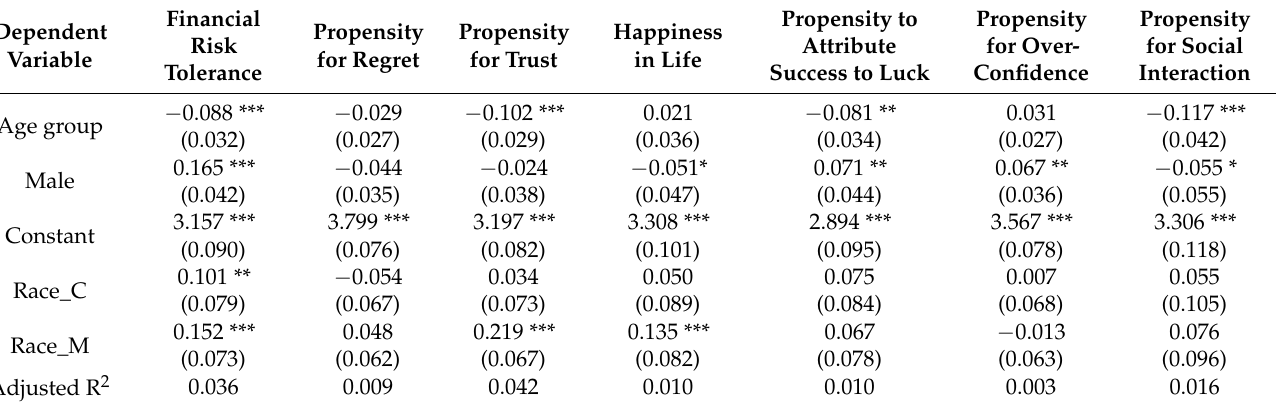
Table 6. Relationships between individual propensities with age, gender, and race: OLS